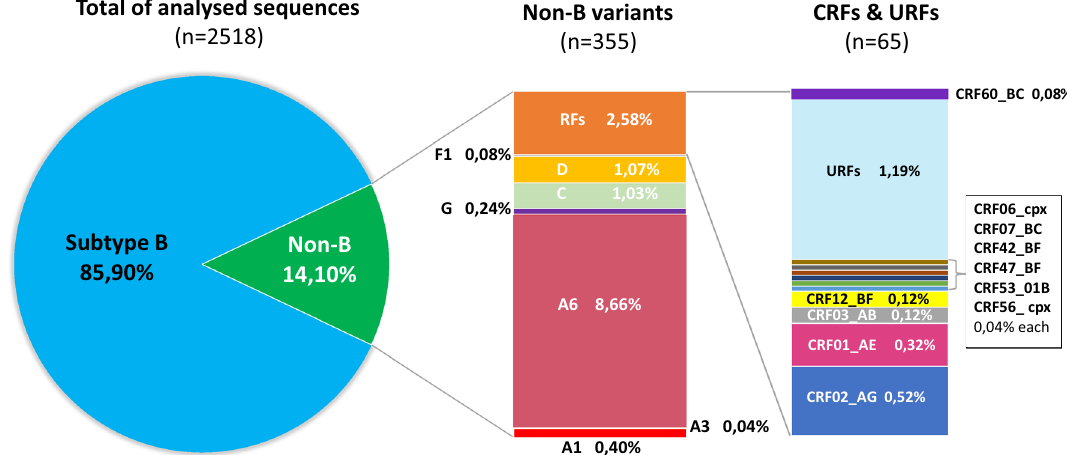
Figure 1. Distribution of HIV-1 variants in Poland between 2015–2019 according to phylogenetic and recombination analyses. RFs—(recombinant forms) comprise of CRF—(circulating recombinant forms) and URFs—(unique recombinant